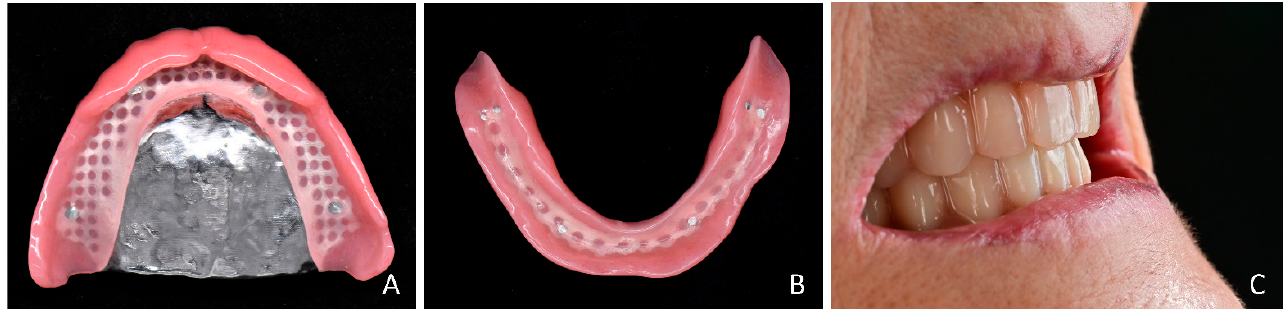
Figure 5. Fabrication of metal-reinforced complete denture extruded by 1 mm.